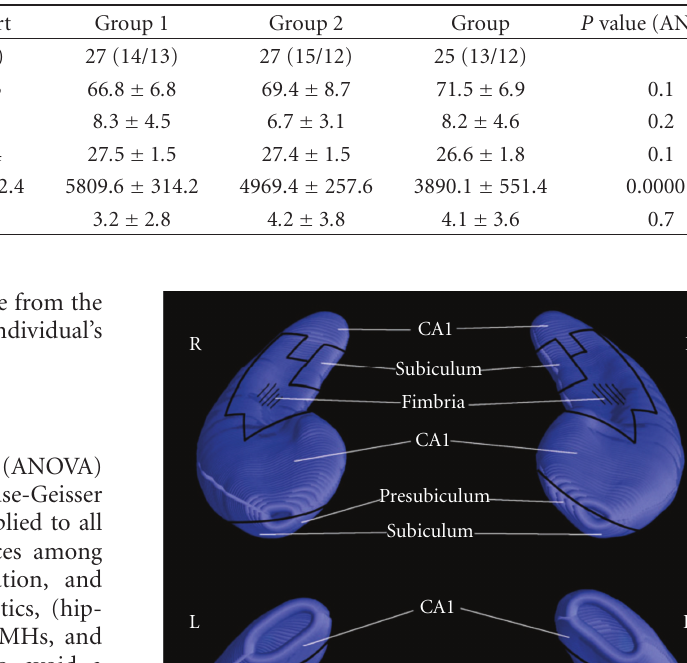
Table 1: Mean values ± standard deviation of sociodemographic characteristics, MMSE scores, white matter hyperintensities, and hippocampal volume measurements in MCI cohort.